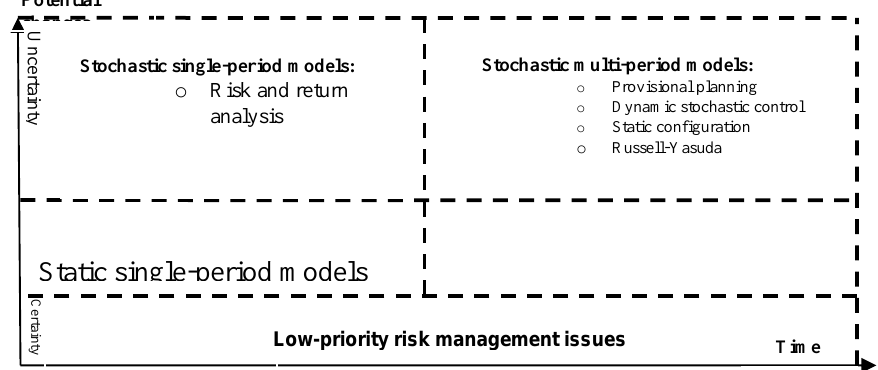
Figure3. Classification of ALM models based on time and associated uncertainties (Source: Xenius and Ziemba,